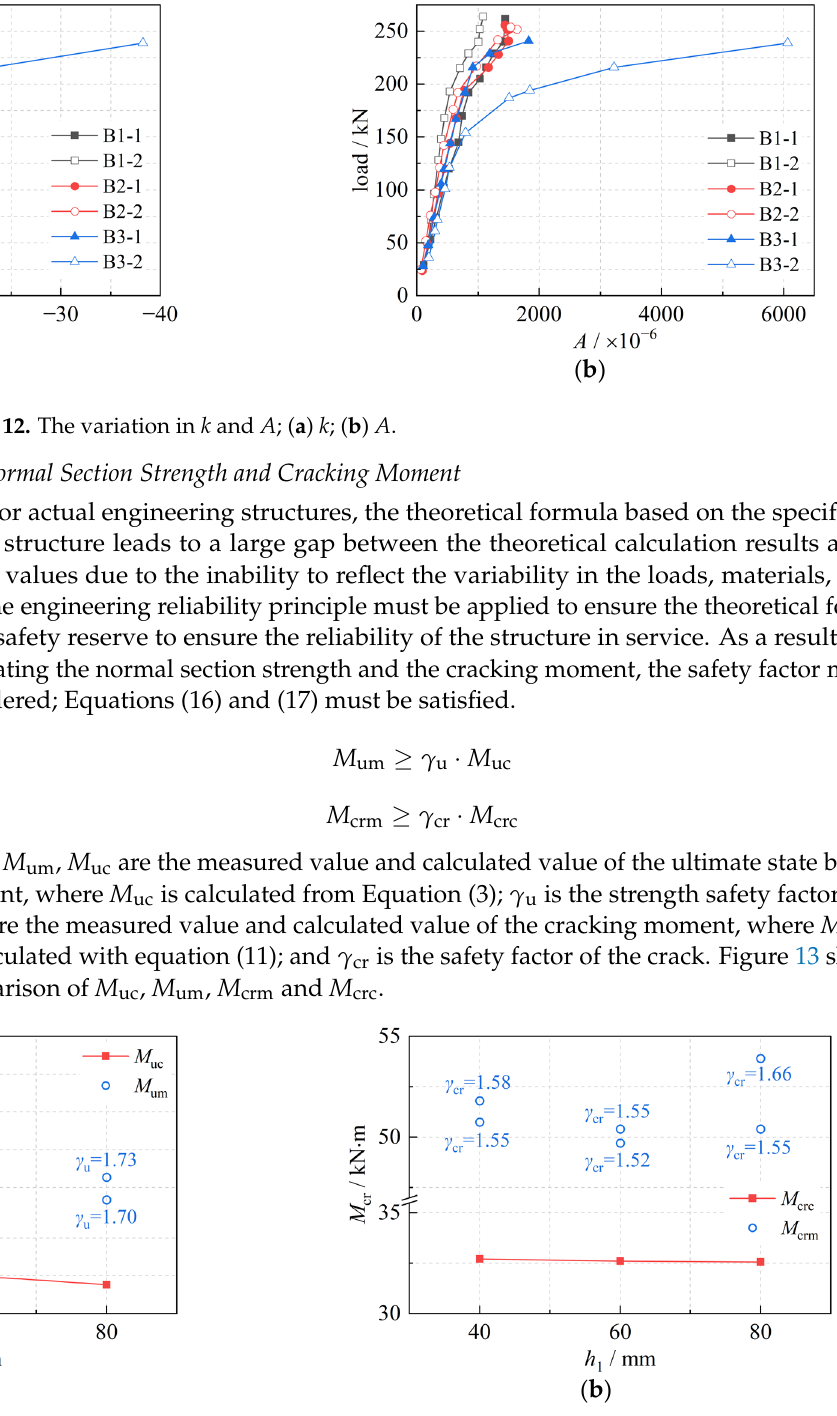
Figure 13. The calculated value and measured value of the normal section strength. ( a ) Ultimate state bending moment; ( b ) cracking moment. bending moment; ( b ) cracking